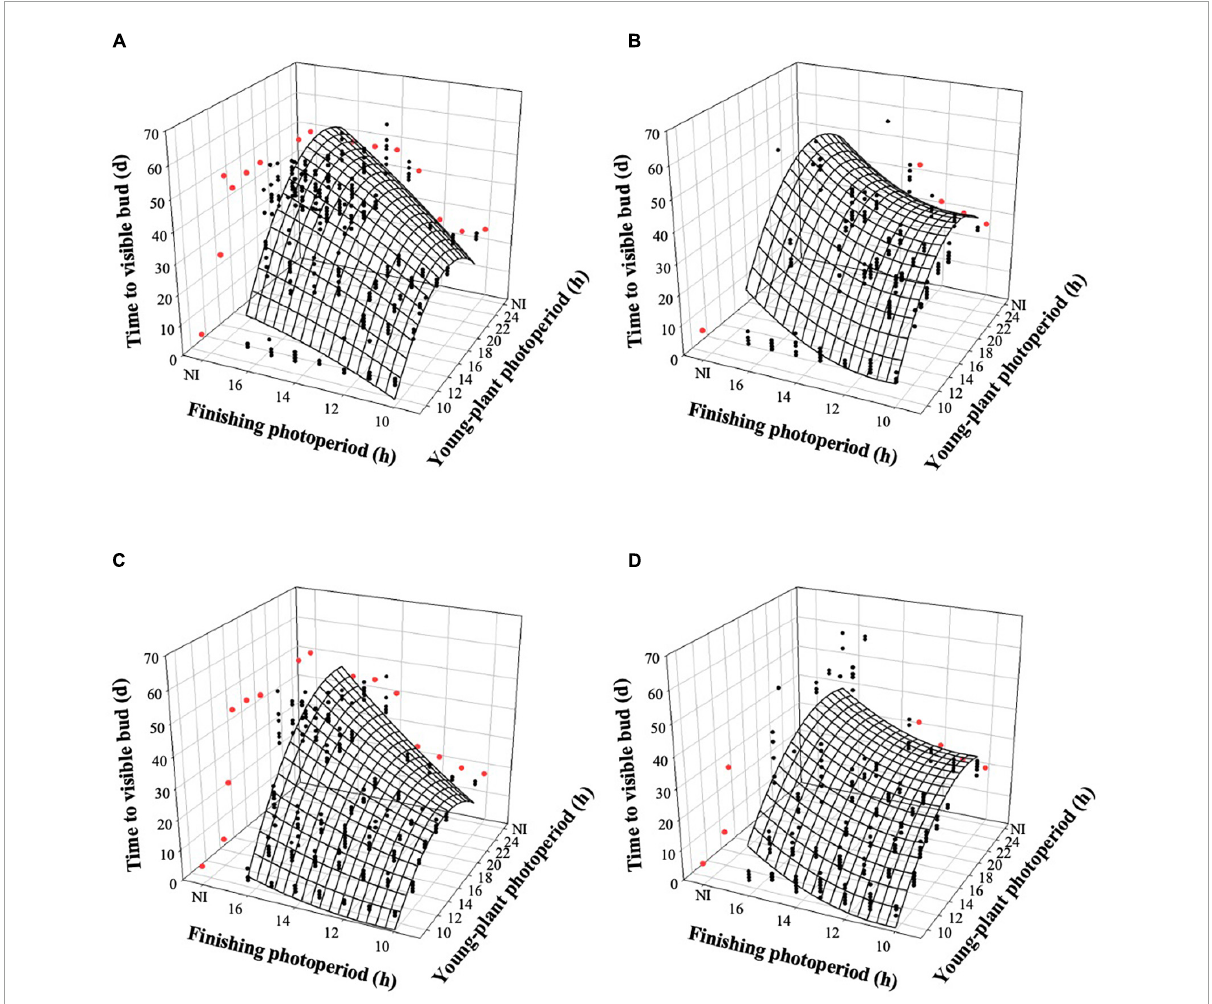
FIGURE2 Effects of young-plant photoperiod (9, 12, 13, 14, 16, 18, and 24 h, or a 4-h NI) and finishing photoperiod (10, 11, 12, 13, 14, 15, and 16 h, or a 4-h NI) on time to visible bud of witchgrass ‘Frosted Explosion’ ( Panicum capillare ). Figures represent (A) moderate-DLI-grown ( ≈ 10 mol · m - 2 · d - 1 ) cut flowers from replication 1, (B) very-low-DLI-grown cut flowers from replication 1, (C) moderate-DLI-grown cut flowers from replication 2, and (D) very-low-DLI-grown ( ≈ 3 mol · m - 2 · d - 1 ) cut flowers from replication 2. Black circles represent individual data points for sequential photoperiods; red circles represent averages from NI treatments. Model predictions are represented by response surfaces; coefficients are presented in Table 8 .